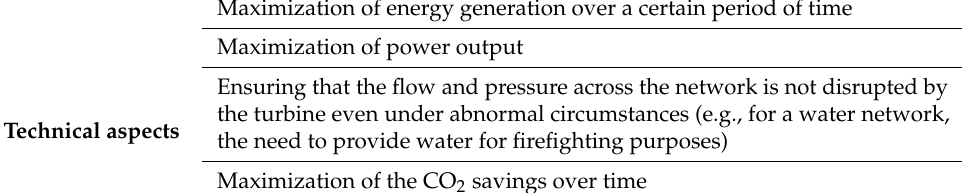
Table 1. Summary of possible technical and economic design parameters relevant to a PAT energy recovery